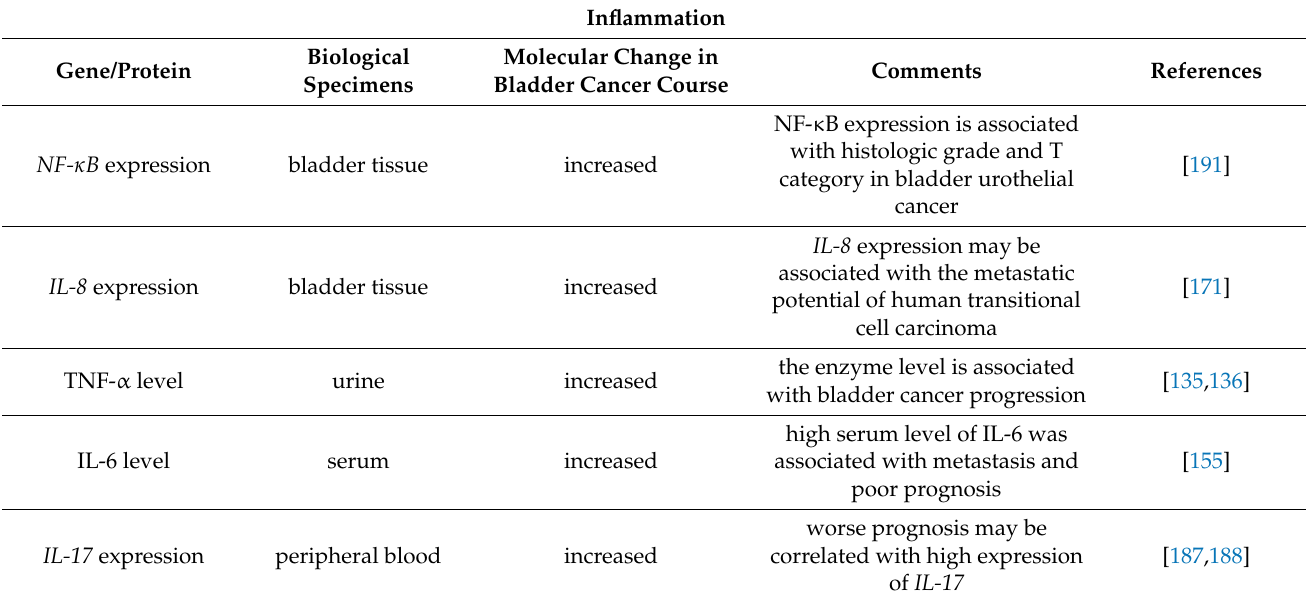
Table 5. The elements of the inflammation involved in bladder cancer